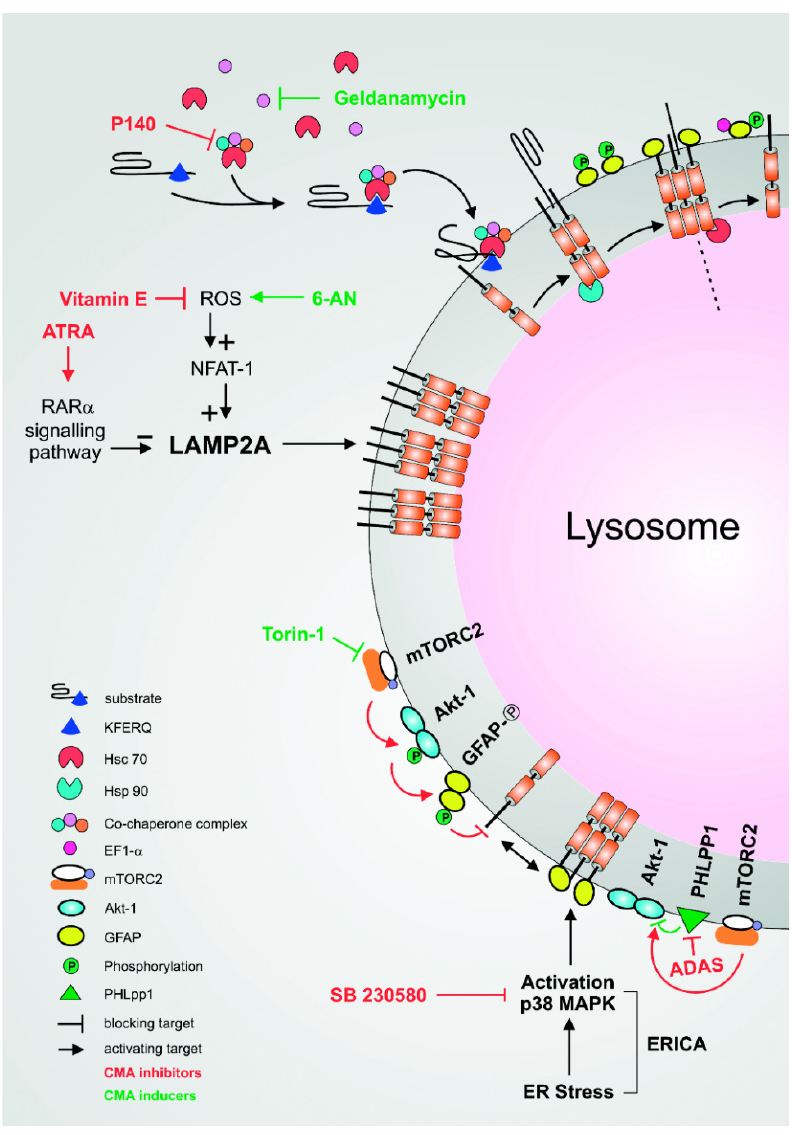
Figure 2. Inducers and inhibitors of CMA. Targeting the chaperone: One potential approach to modulate CMA involves the direct targeting of the chaperone such as Hsp90. Through the inhibition of the ATPase activity of Hsp90, Geldanamycin acts as an inducer of CMA. Conversely, the